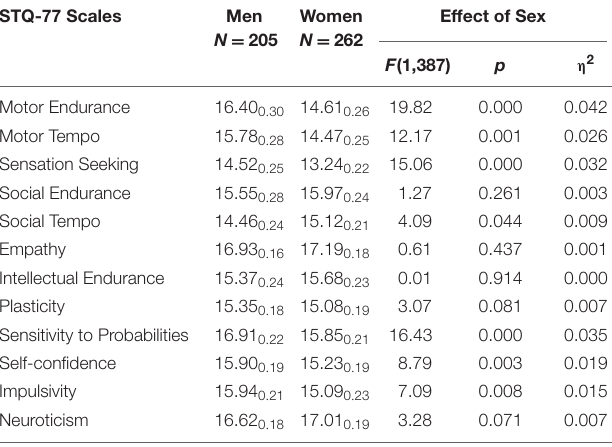
TABLE 4 | Means and Standard Deviations ( M SD ) on the STQ-77 scales for groups contrasted by Sex (all Men combined vs. all Women combined), and the ANOVA